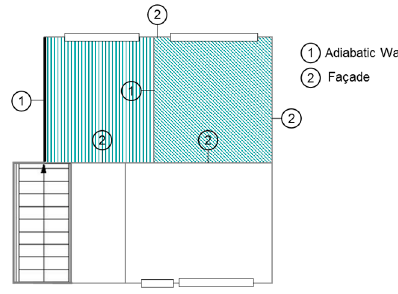
Figure 3. Floor plan of a part of the multi-family house constructed between 1958–1968 [18].